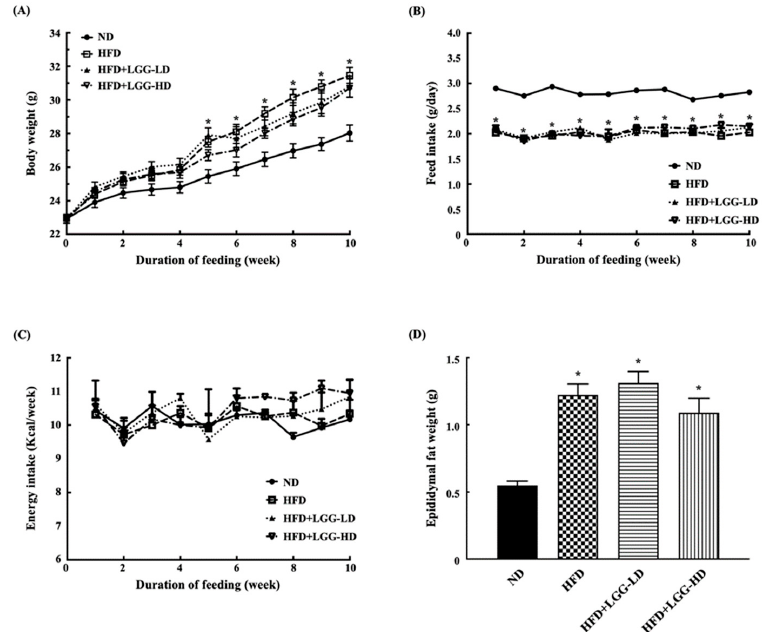
Figure 1. Effect of administration of Lactobacillus rhamnosus GG (LGG) on physiologic parameters in mice with diet-induced obesity. ( A ) Body weight. ( B ) Feed intake. ( C ) Energy intake. ( D ) Epididymal fat level. ND: normal diet; HFD: high-fat diet; HFD + LGG-LD: high-fat diet supplemented with low-dose LGG (10 8 CFU / mouse / day); HFD + LGG-HD: high-fat diet supplemented with high-dose LGG (10 10 CFU / mouse / day). All data are expressed as mean ± SD ( n = 10). Bar marked with a star * means that it is significantly different from the ND group at p < 0.05.